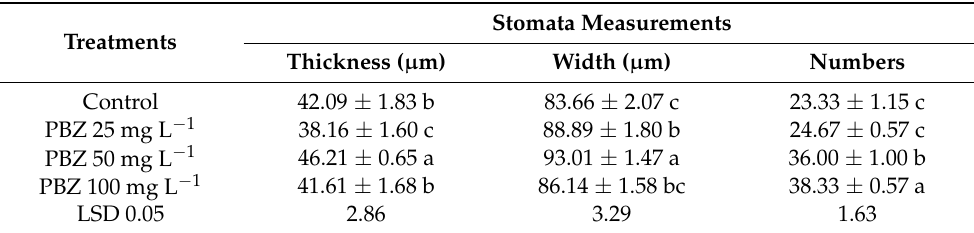
Table 7. Stomata measurements of tomato leaves, as affected by PBZ treatments (after 10 days from PBZ application and without infection by Alternaria solani ).